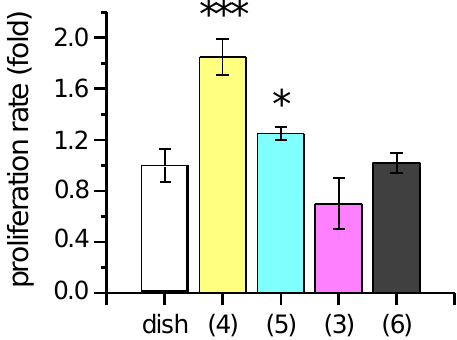
Figure 2. Proliferation rate of F-11 cells seeded and maintained for seven days on di ff erent neoglycosylated collagen matrices: ( 4 ) sialyl α -(2 → 6)-galactoside, ( 5 ) sialyl α -(2 → 3)-galactoside, ( 3 ) β -galactoside, ( 6 ) chondroitin sulphate. * p < 0.05, *** p < 0.001.